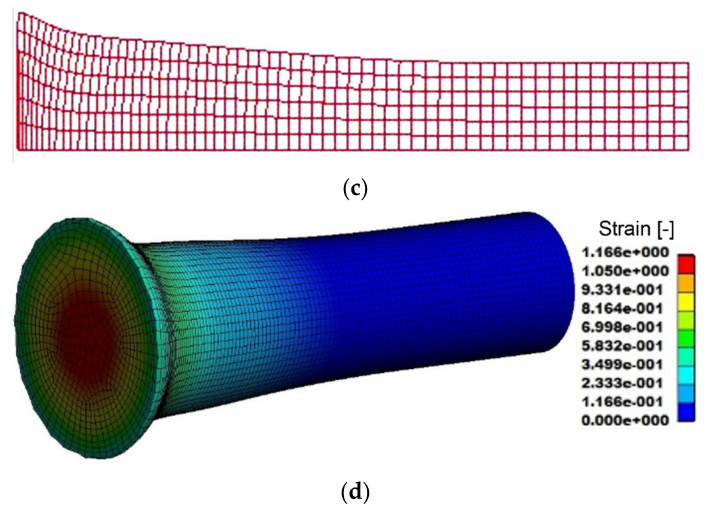
Figure 10. Numerically predicted distributions of: YZ stress component ( a ); compressive stress ( b ); 0.5 mm × 0.5 mm superimposed grid (axial longitudinal cut through tested specimen) ( c ); effective imposed strain ( d ).